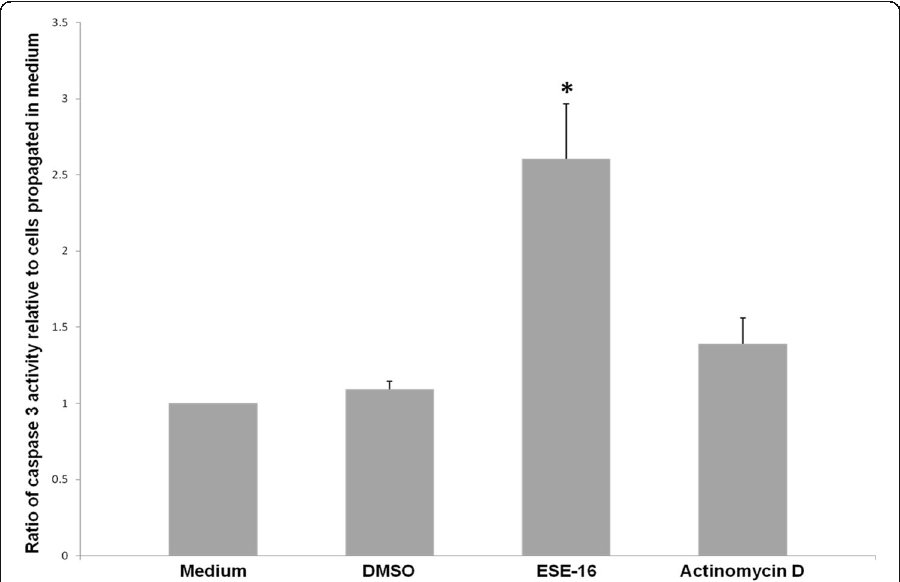
Fig. 15 Bar graph illustrating the ratio of caspase 3 activity of vehicle-treated control, ESE-16-treated and actinomycin D-treated cells relative to cells propagated in medium after 24 h exposure. Compound-treated cells showed a statistically significant increase in the presence of caspase 3 compared to vehicle-treated control cells. * p <